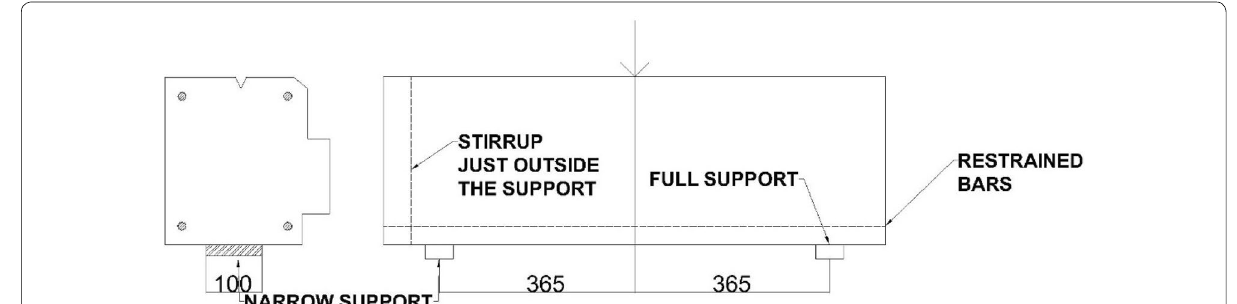
Fig. 9 Directly supported three-point-bending test setup. Dimensions are in